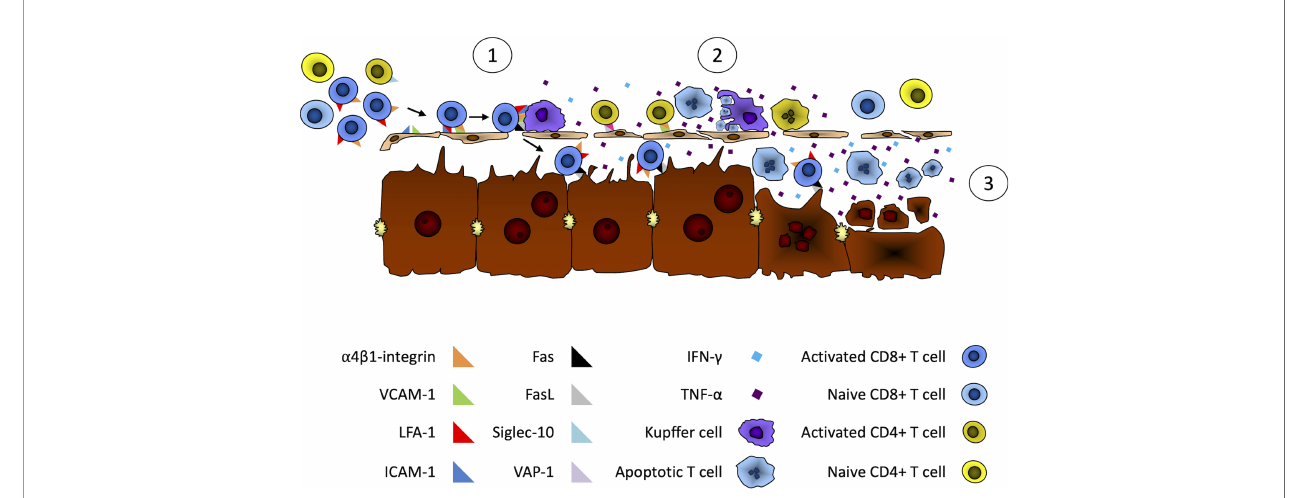
FIGURE 1 | Putative mechanisms of liver damage during immune checkpoint inhibitor cancer immunotherapy. We propose the following series of events leading to liver damage during ICI therapy. 1) Adhesion of activated T cells in hepatic sinusoids. First, activated CD8+ T cells would be trapped by the liver through binding of their a 4 b 1-integrin to LSECs and Kupffer cell-expressed VCAM-1 and ICAM-1. Activated CD4+ T cells could also be retained by the liver through a 4 b 1-integrin and Siglec-10 binding to LSECs- and Kupffer cell-expressed VCAM-1 and VAP-1. 2) Apoptosis of activated T cells. Following their retention in the liver, activated T cells Fas death receptor would bind FasL expressed on LSECs and Kupffer cells. This Fas/FasL interaction and the IFN-gamma secretion by activated CD8+ T cells would induce the expression and secretion of TNF- a by Kupffer cells. This would lead to the apoptosis of activated T cells by both Fas/ FasL interactions and the ligation of TNF- a to their tumor necrosis factor receptor 1 (TNFR1). Apoptosis could also occur through binding of LSECs- and Kupffer cell-expressed TRAIL with TNF-related apoptosis-inducing ligand receptor (TRAILR) expressed on activated T cells. 3) Apoptosis of hepatocytes. The activation of Kupffer cells by activated T cells through the combined effect of Fas/FasL ligation and Interferon-gamma secretion by activated T cells would lead to the secretion of large amounts of cytotoxic TNF- a by Kupffer cells. This would sensitize hepatocytes that would then be susceptible to Fas-induced and IFN- gamma-mediated apoptosis by in fi ltrating activated T